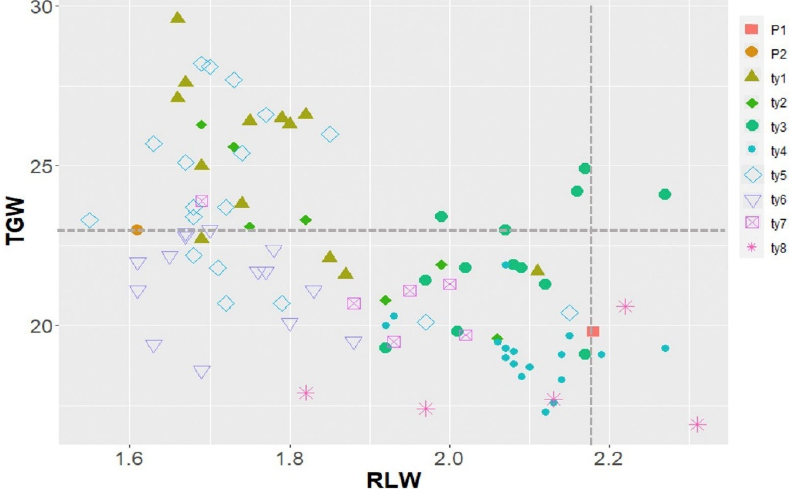
Figure 5. Scatter plot of the ratio of length to width (RLW) and 1000-grain weight (TGW) in 89 lines without heterozygous distribution based on the eight QTL combination types. P1: Boramchan; P2: Pecos; ty1–ty8: eight QTL combinations. Table 3. Haplotype test for the parents, Pecos and Boramchan, using eight specific DNA markers to characterize genes associated with grain